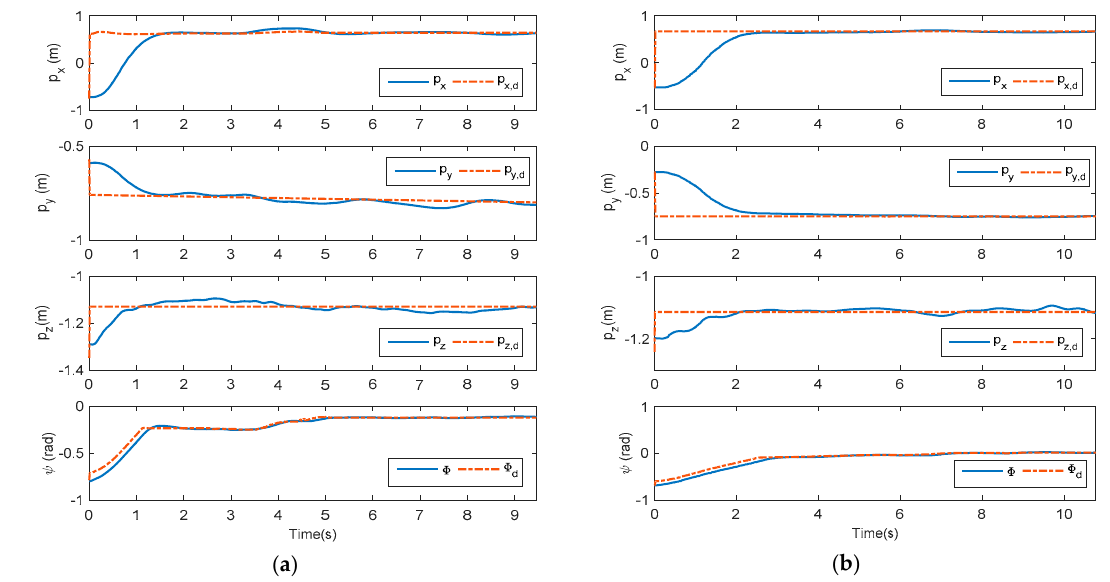
Figure 8. The position and yaw angle of the hex-rotor: ( a ) The hex-rotor is controlled without the acceleration feedback enhance term; ( b ) The hex-rotor is controlled with the acceleration feedback enhance term.